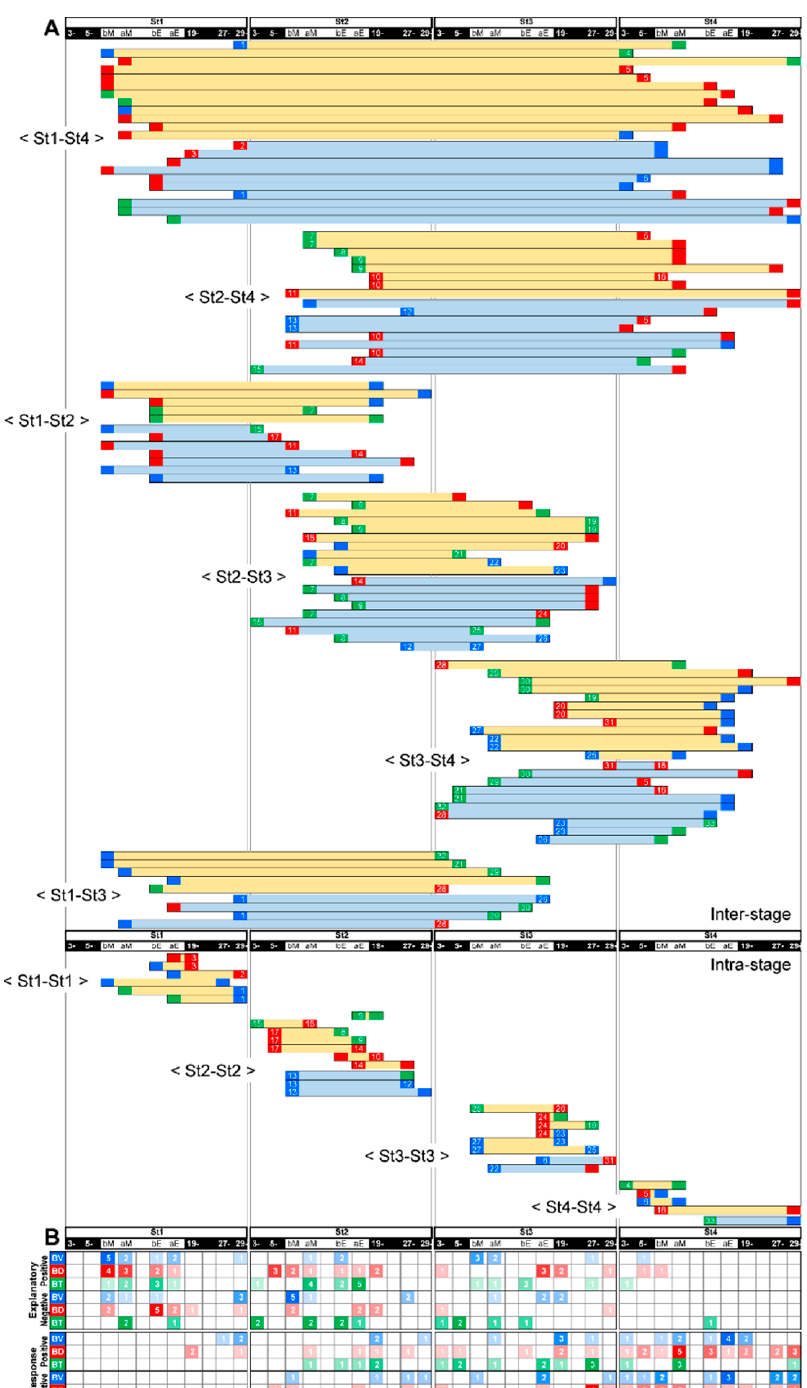
Figure 8. Feeding-dependent pathways of B-variables by LMMs. Age-stage and focal time are arranged horizontally in the time series. ( A ). Light yellow and light blue horizontal bars indicate positive and negative correlation vectors between explanatory (left side of the bars: start) and response (right side of the bars: end) variables, respectively. ( B ). The heat maps represent the summed number (color gradation) of positive or negative BV (V, blue), BD (D, red) and BT (T, green) as explanatory ( upper ) or response ( lower ) variables per focal time in each age-stage.